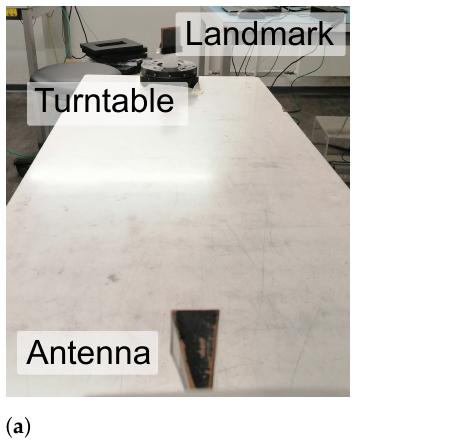
Figure 4. Cluttered set-up for low-Q landmark. ( a ) Clutter set-up for low-Q tag. ( b ) Closer view on the moving clutter